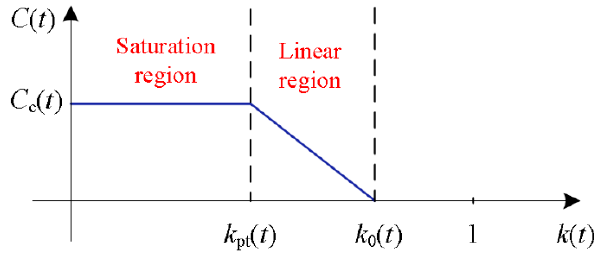
Figure 3. Relationship between compensation amount C ( t ) and power supply degree k ( t )